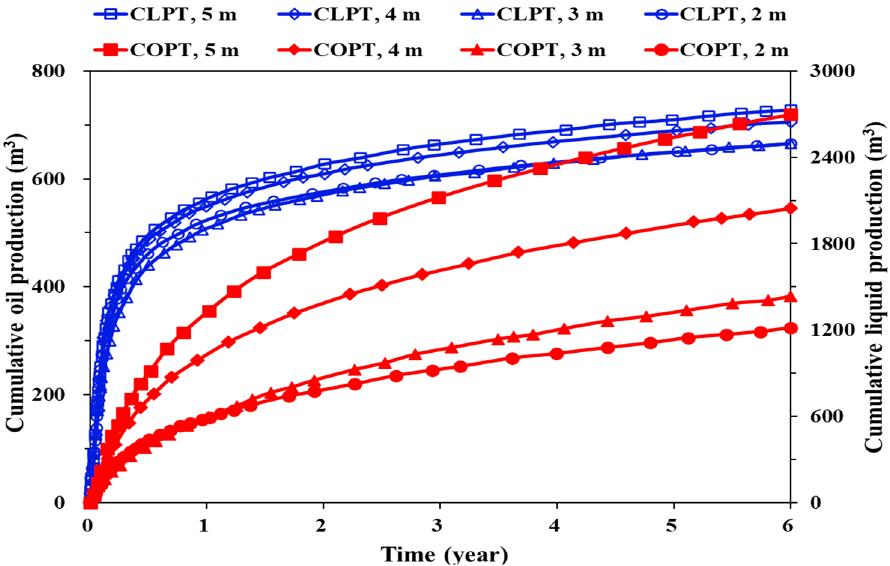
Figure 16. Production performance curves of different payzone thickness values (6 years of production).